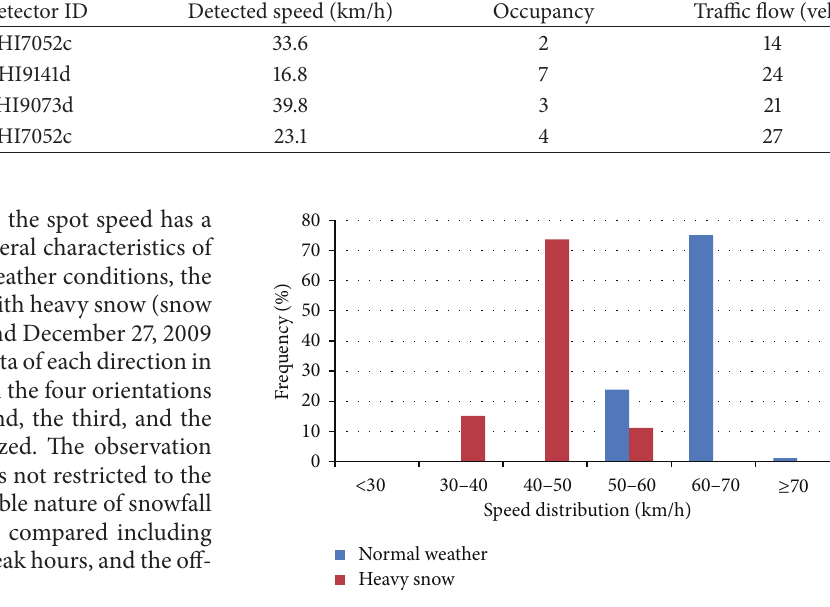
Figure 1: Spot speed distribution difference under the same traffic volume